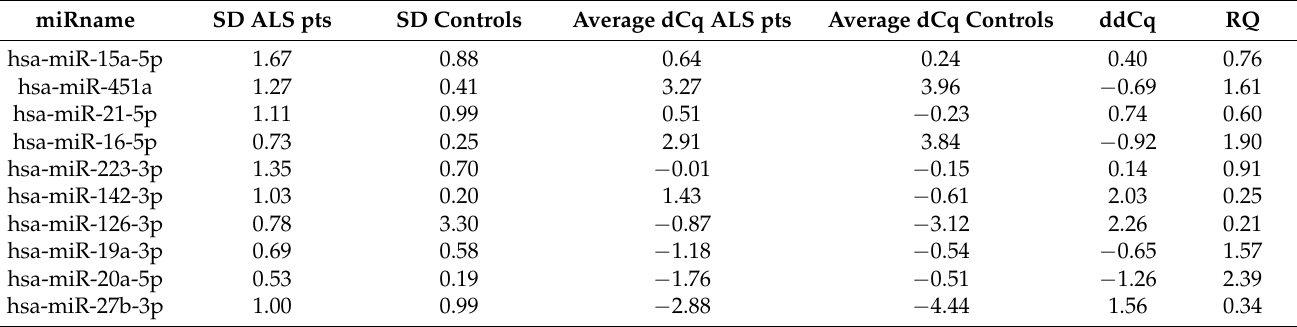
Table 2. Expression profile of the 10 miRNAs detectable in every six samples selected in a second step based on their best